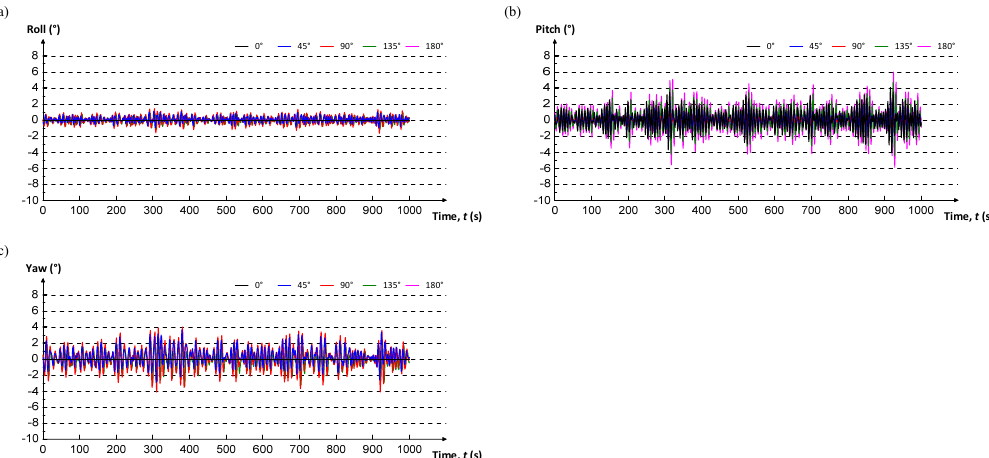
Figure 18. Rotational responses against different approaching wave directions under normal wave conditions. ( a ) Roll; ( b ) Pitch; ( c ) Yaw. Processes 2021 , 9 , x FOR PEER REVIEW